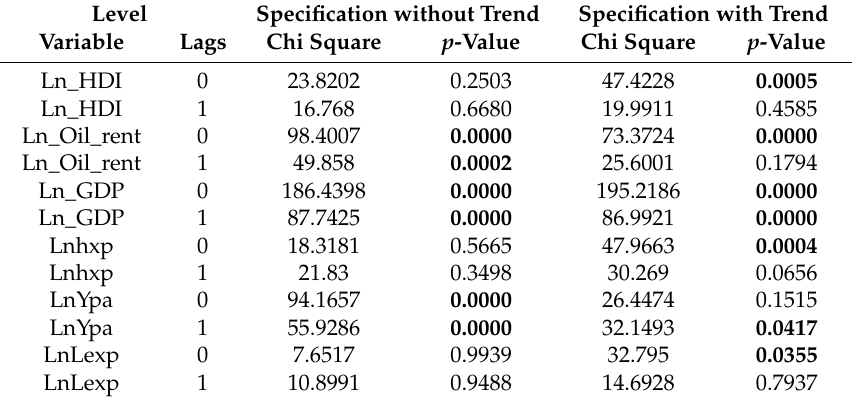
Table 8. Maddala and Wu, (1999) ADF unit roots test results.